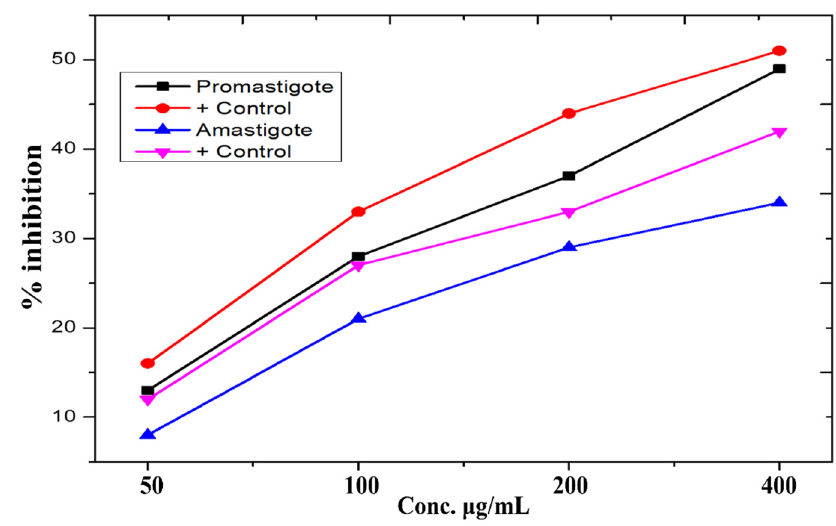
Figure 6. % Mortality of amastigote and promastigote parasites potential of ZnO-NPs .